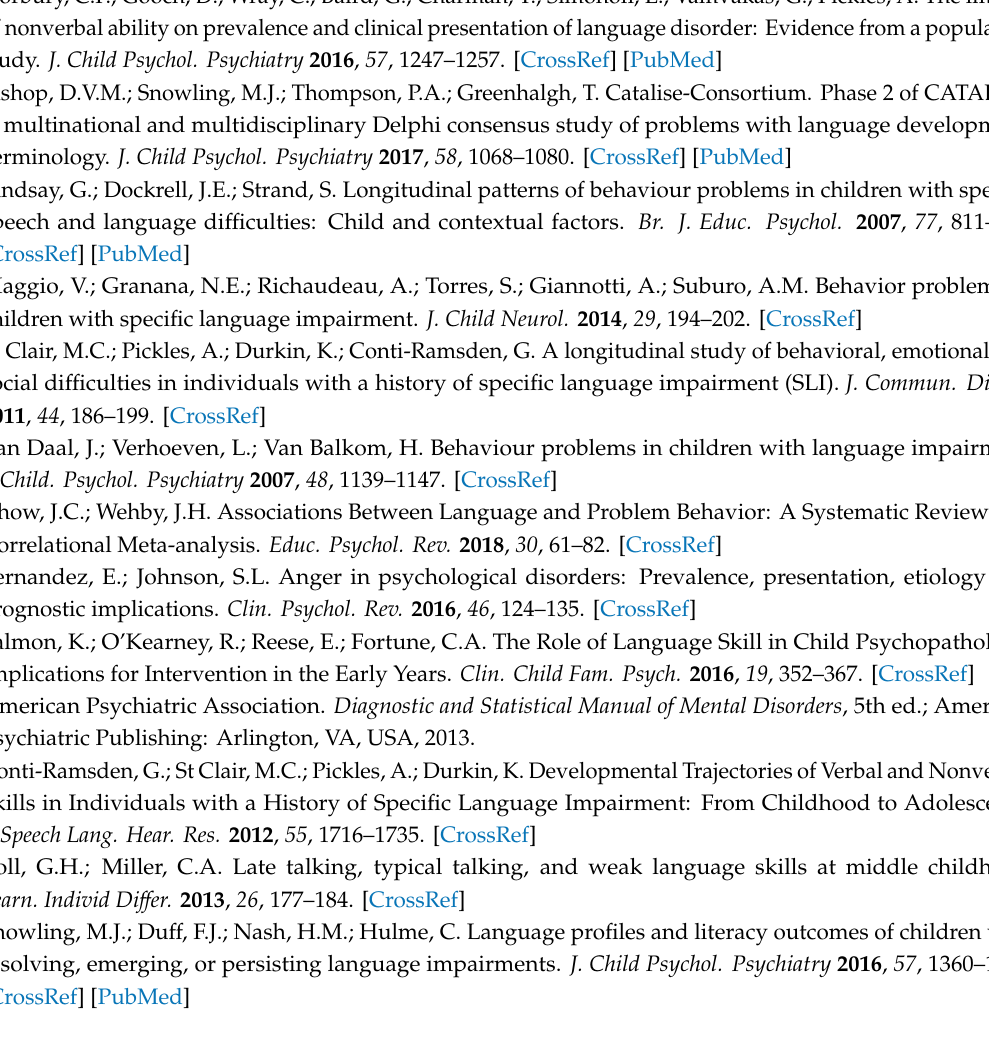
Table S1: Goodness of fit (AIC and log likelihood test) of the di ff erent models, Table S2: Pearson’s correlations between all variables with in the upper right corner the correlations for all children together and in the bottom left corner the correlations separately for the two groups (children without DLD / children with